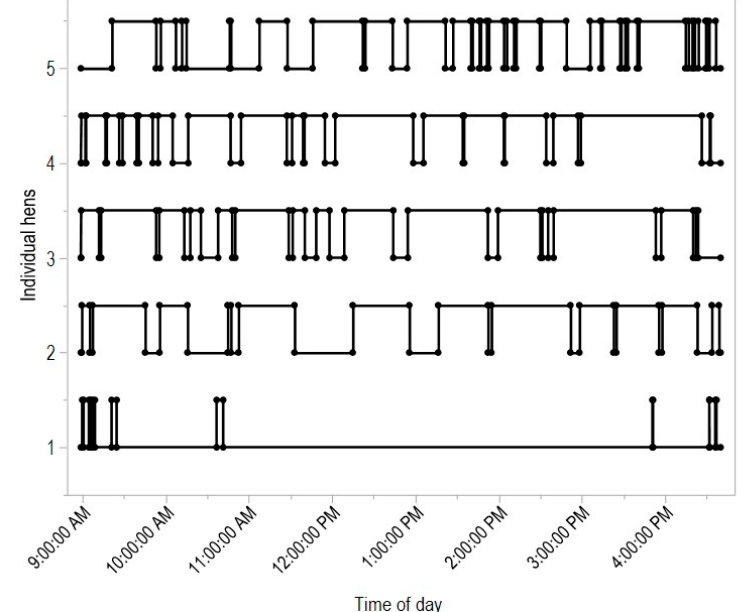
Figure 6. Examples of individual hen movements representing the 5th, 15th, 25th, 35th and 45th most movements during the day for a single pen (non-enriched). A high position indicates that the hen is outside at that time and low position that the hen is inside.